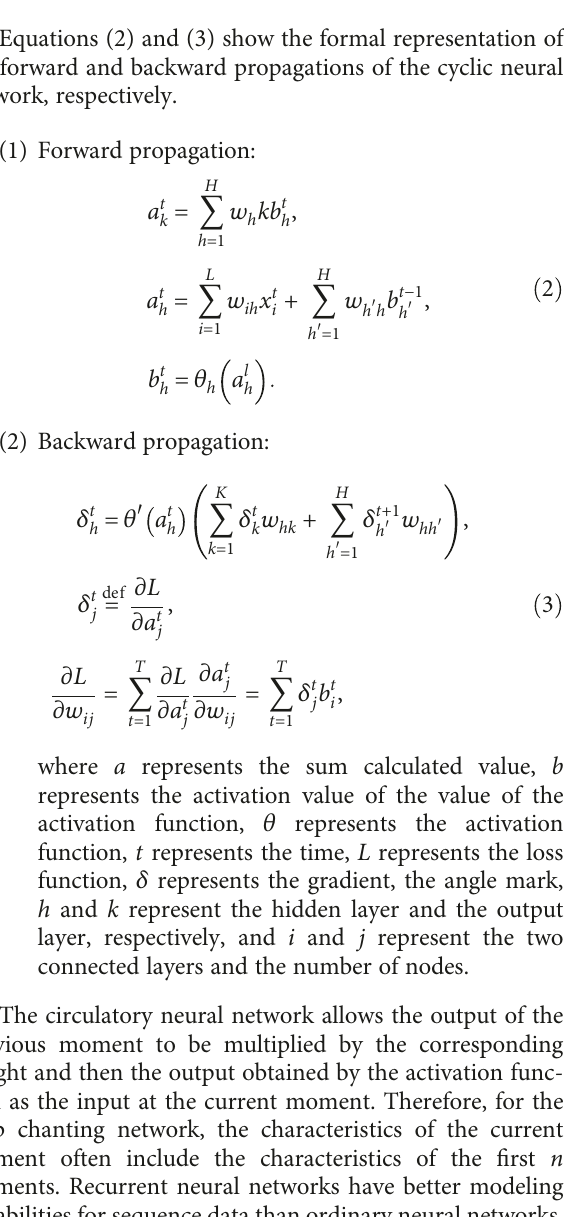
Figure 7: Recurrent neural network extends on time